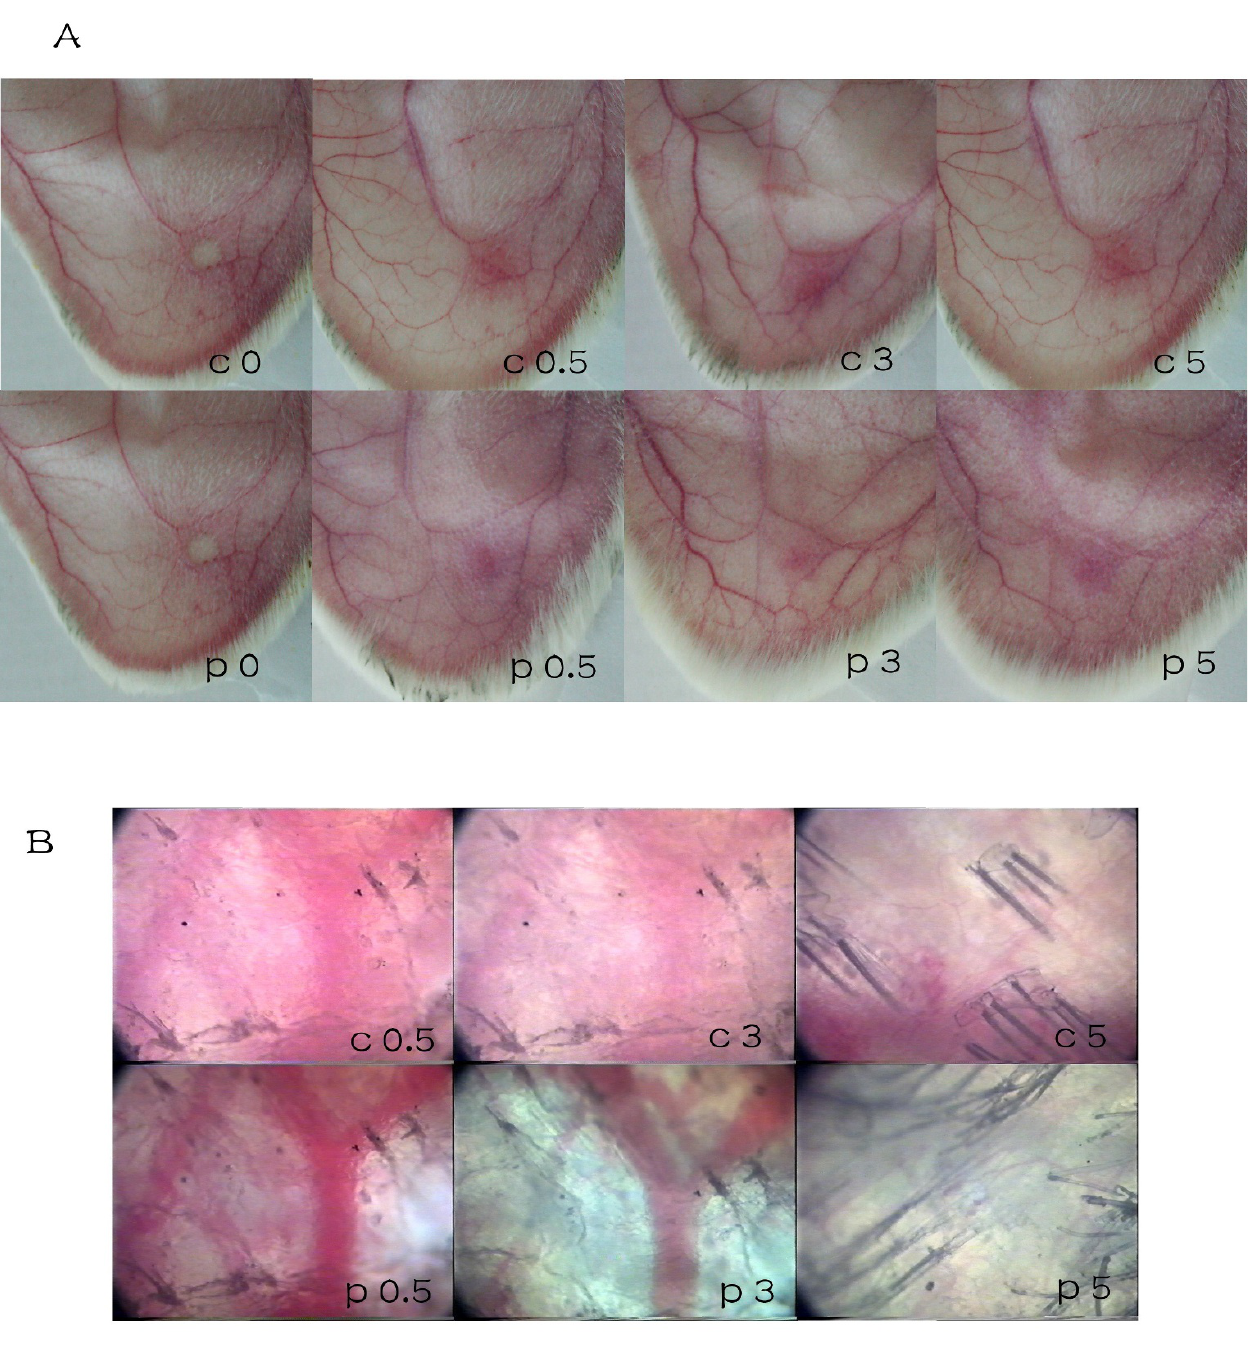
Figure 4 CSTI area photographed at different hours . Rabbit ears CSTI area photographed at different hours (0, 0.5, 3 and 5 hours). Macroscopically visible increase of CSTI area swelling and redness in control group as compared with PRP group before and after application of 0.9% NaCL (C0–C5: controls) or PRP extracts (P0–P5: PRP) (A), and the photograph under microscope